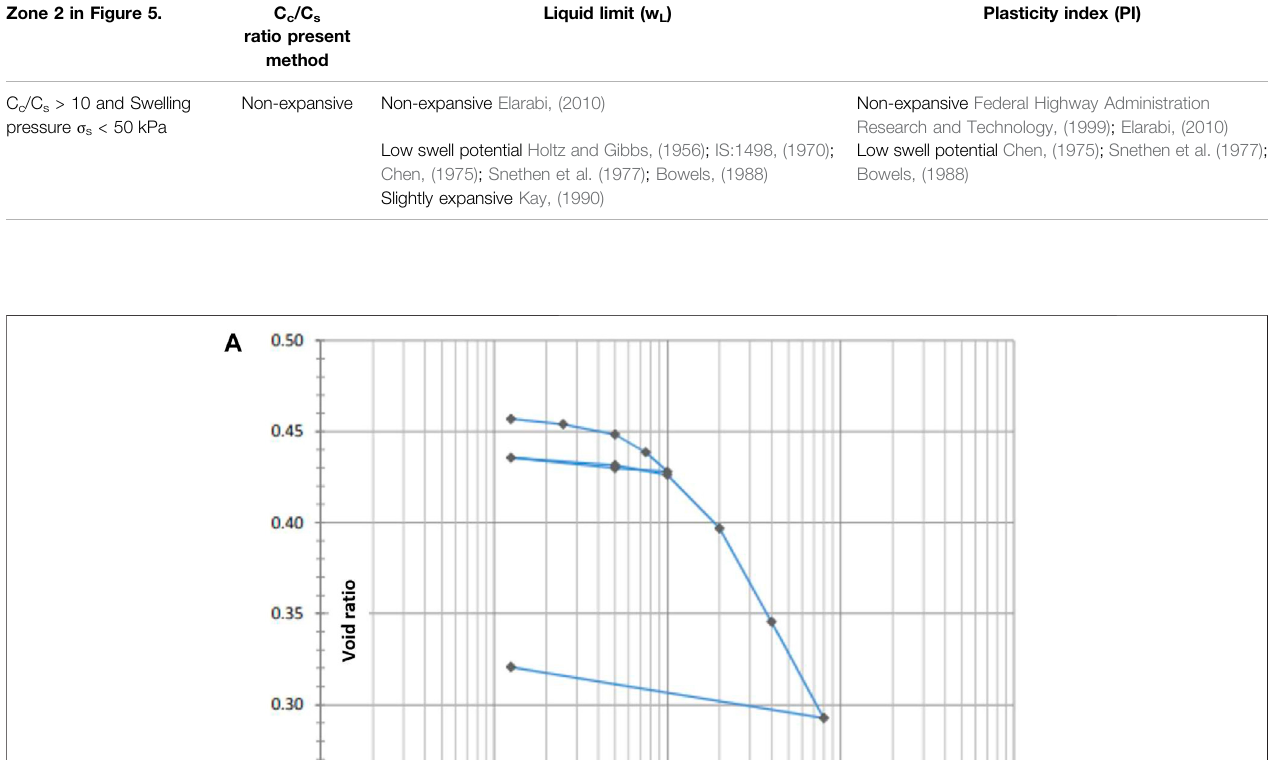
Frontiers in Built Environment |